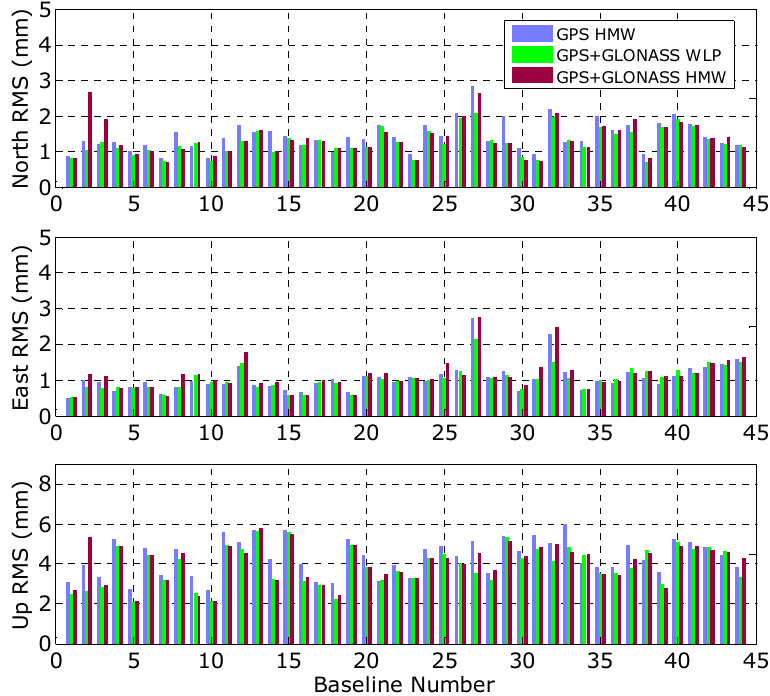
Figure 8. Position RMS (root mean square) for the GPS Only and GPS+GLONASS daily static baseline solutions.